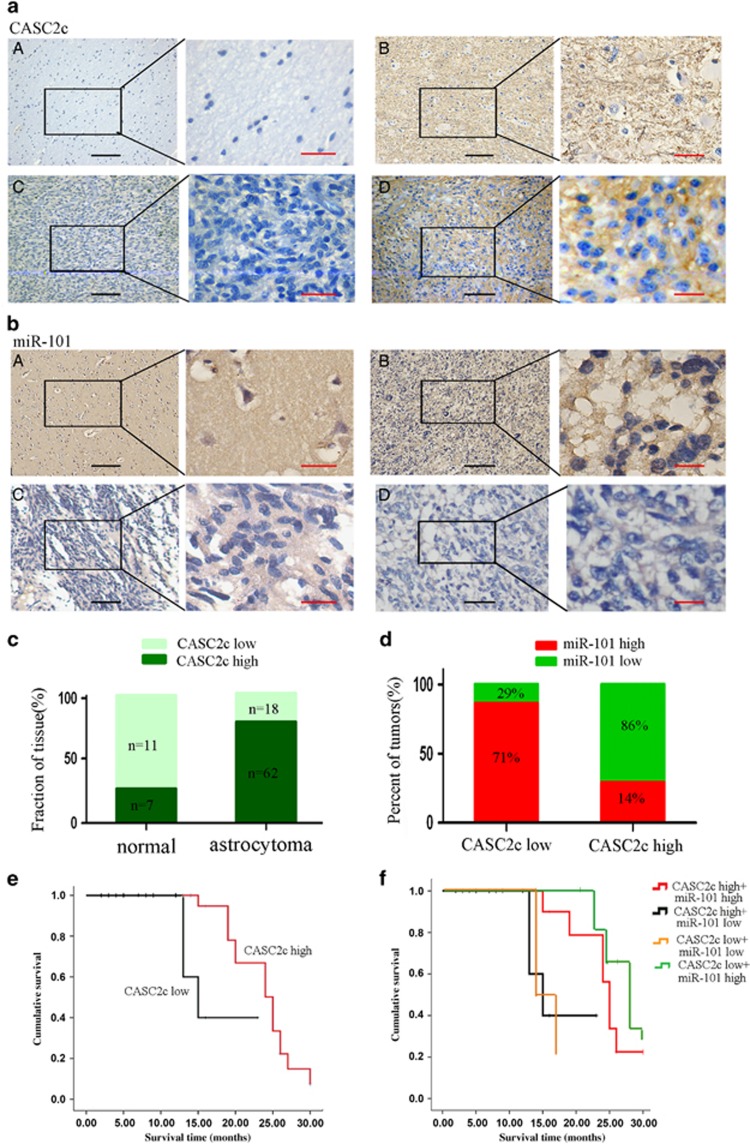
Association between miR-101 and CASC2c expression in astrocytoma clinical samples. (a and b) The expression level of CASC2c and miR-101 was detected by in situ hybridization. Black scale bars, 200 μm; red scale bars, 20 μm. (c) ISH score breakdown for a panel of normal tissues and astrocytoma. Each patient sample was scored from triplicate representative tumor cores, and the average CASC2c ISH score was recorded as low (score⩽8) or high (score>8). (d) The correlation between CASC2c expression and miR-101 levels were analyzed using Spearman's rank test. (e) Kaplan–Meier analysis for overall survival in 80 astrocytomas in high- and low-risk groups based on CASC2c expression levels. (f) Kaplan–Meier analysis for overall survival in 80 astrocytomas in high- and low-risk groups based on CASC2c and miR-101 expression levels